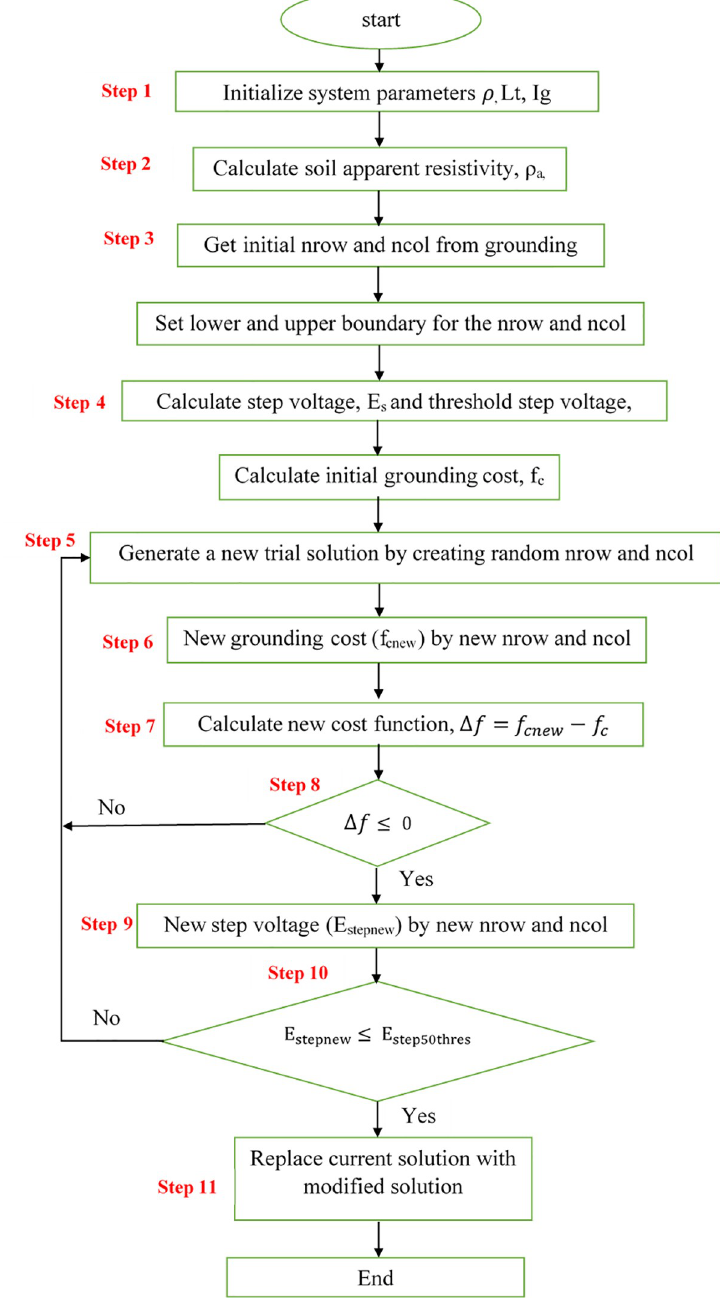
Fig 2. Flowchart of grounding system design optimization using Simulated Annealing algorithm.